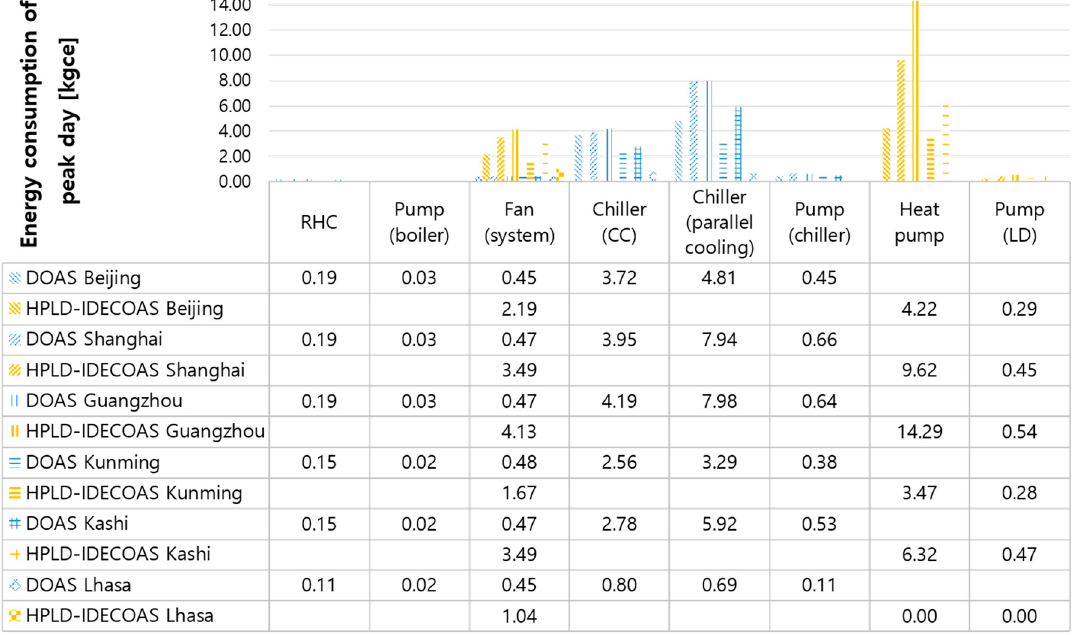
Figure 12. Comparison of energy consumption for the peak day in each selected city.